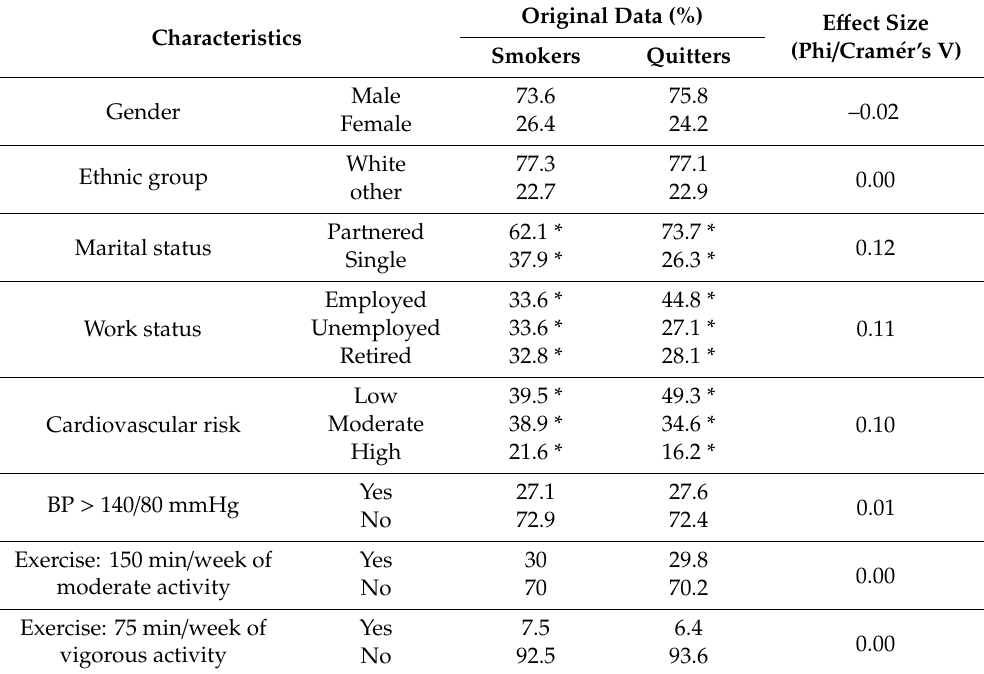
Table 3. Crosstabulation of baseline characteristics of smokers and quitters who participated in cardiac